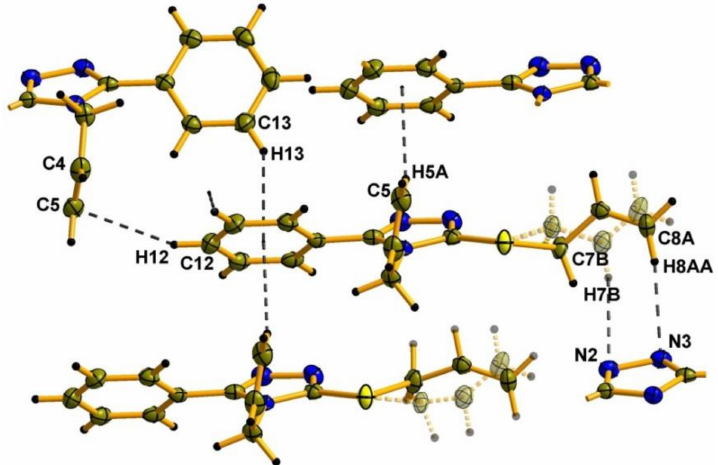
Figure 3. The weak interactions between the molecules in Atr crystal